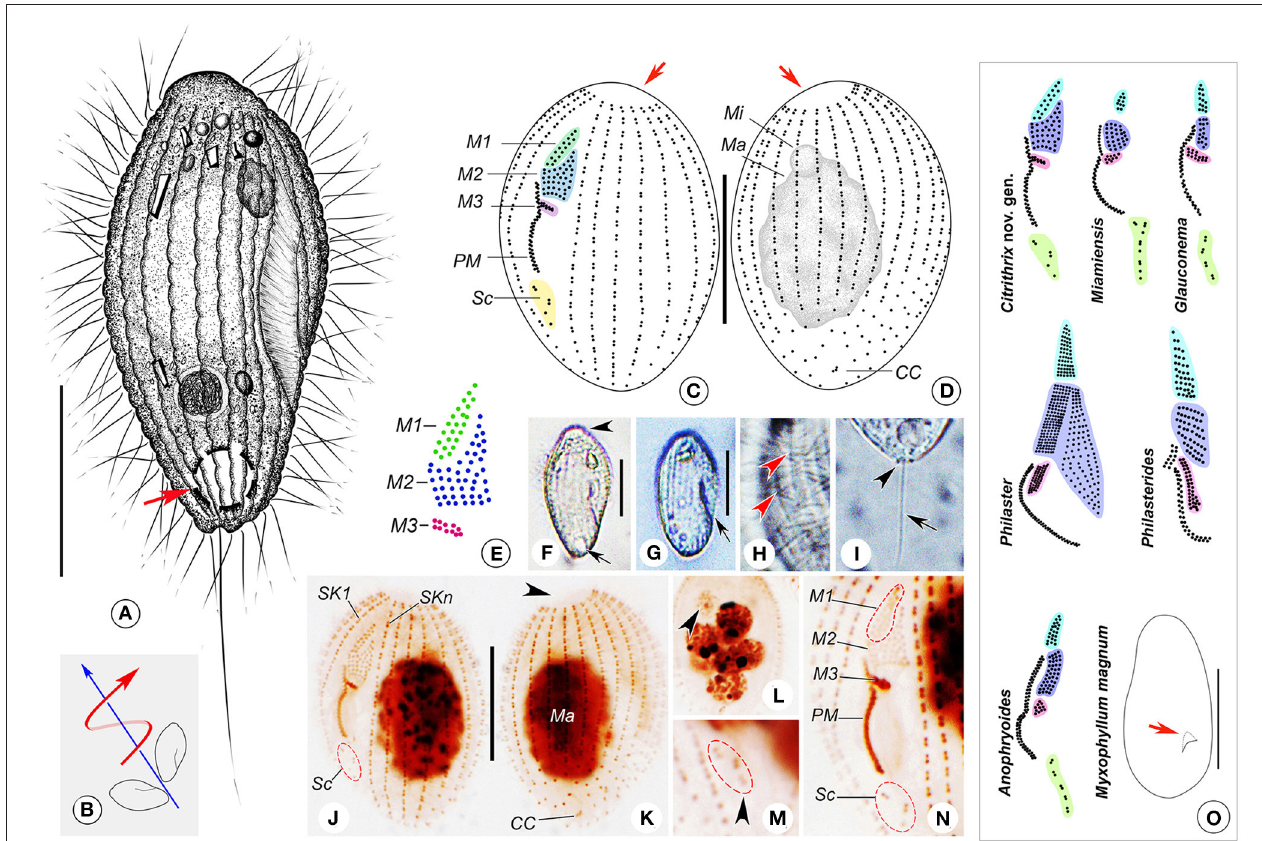
FIGURE 2 | (A–O) Citrithrix smalli sp. nov. from life (A,B,F–I) , after protargol staining (C–E,J–N) , and a comparison with related genera (O) . (A) Right ventrolateral view of a representative cell, arrow shows the contractile vacuole. (B) Swimming trace, red arrow indicates the body rotation, blue arrow shows the swimming direction. (C,D) Left ventrolateral (C) and right dorsolateral (D) views of the holotype specimen, arrows indicate the apical plate. (E) Oral structure showing three-rowed membranelle 1. (F,G) Right ventrolateral views, showing the variation in body shape, arrow and arrowhead in F point to the apical plate and contractile vacuole, respectively, arrow in G indicates the oral groove. (H) Detail of pellicle, arrowheads mark the grooves on the ciliary rows. (I) Lateral view of rear end of cell, arrowhead points to the small depression at basal position, arrow indicates the caudal cilium. (J,K) Left ventrolateral (J) and right dorsolateral (K) views of the holotype specimen, arrowhead shows the glabrous apical plate. (L) Nuclear apparatus of an individual with several macronuclear nodules, arrowhead indicates the micronucleus. (M) Arrowhead marks the scutica. (N) Detailed view of oral apparatus. (O) An oral structure comparison with related genera and a body size and shape comparison with Myxophyllum magnum , all redrawn based on previous studies except for the new genus ( Cawthorn et al., 1996; Song, 2000; Song and Wilbert, 2000; Xu and Song, 2000; Ma et al., 2006; Pan et al., 2015b ). Arrow in M. magnum points to the buccal field. CC, caudal cilium; M1–3, membranelle 1–3; Ma, macronucleus; Mi, micronucleus; PM, paroral membrane; Sc, scutica; SK1, somatic kinety 1; SKn, somatic kinety n. Scale bars: 15 µ m (A,C,D,F,G,J,K) ; 100 µ m (O)